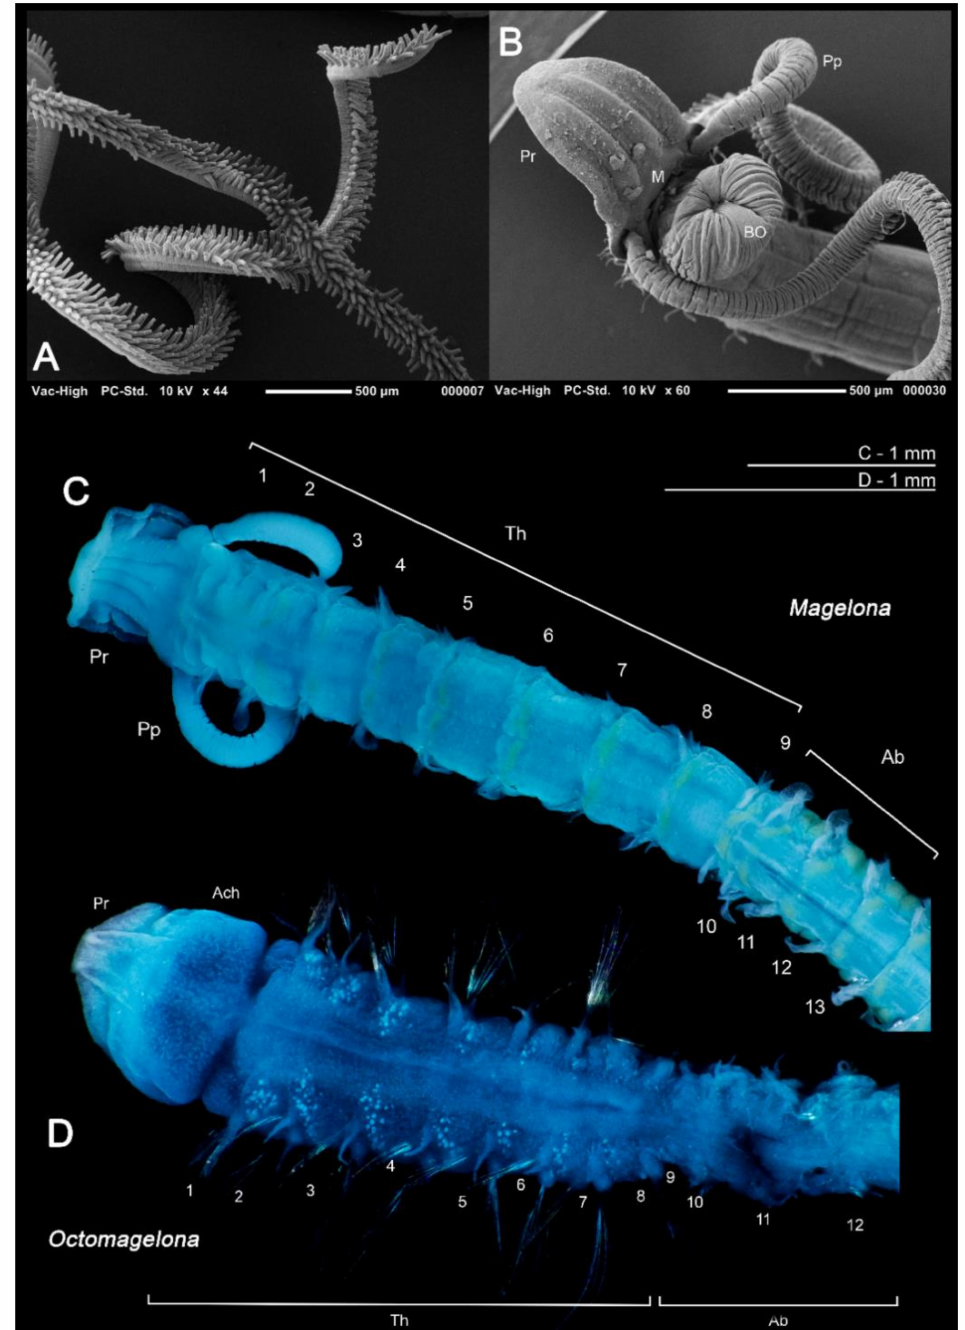
Figure 2. ( A ) Papillated palps of Magelona johnstoni ; ( B ) anterior thorax of M. johnstoni showing partially everted burrowing organ, mouth at prostomium base, and basal portion of the palps (ventral view); ( C ) M. gemmata (dorsal view); ( D ) un- described species of Octomagelona from Western Africa (dorsal view). Abbreviations: Ab—abdomen, Ach—achaetous first segment, BO—burrowing organ, M—mouth, Pp—palp, Pr—prostomium, Th—thorax. Numbers indicate chaetiger. ( C , D ) stained with methyl